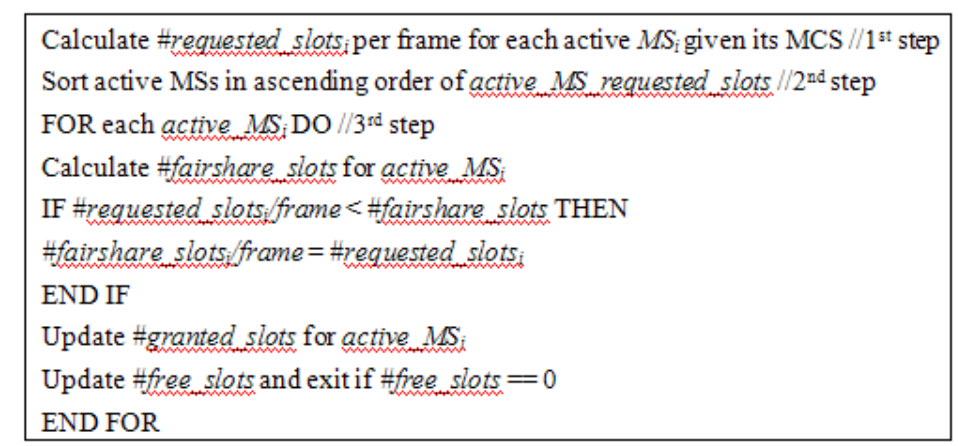
Figure 2. Steps in a Simple Max-Min Fairness Algorithm [10].